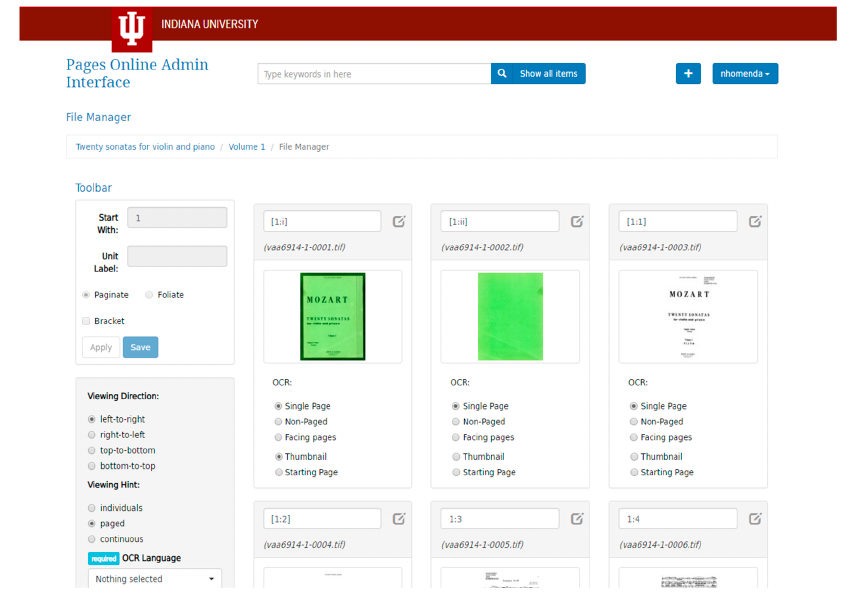
Figure 4. Indiana University’s Pages Online administrative interface, allowing collection managers to describe, paginate, order, structure, and set access levels for uploaded items.